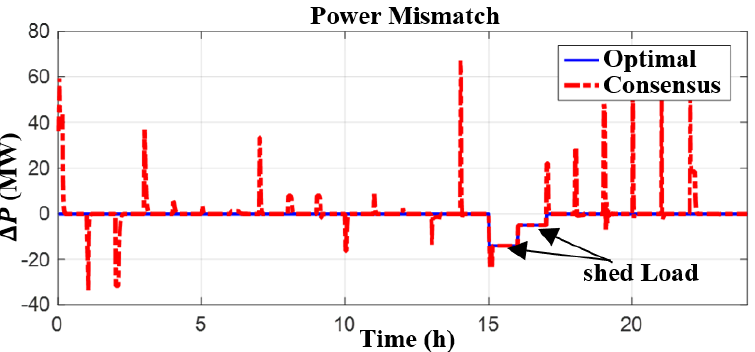
Figure 14. The incremental cost of generators and utility rates in heavy-load scenario.